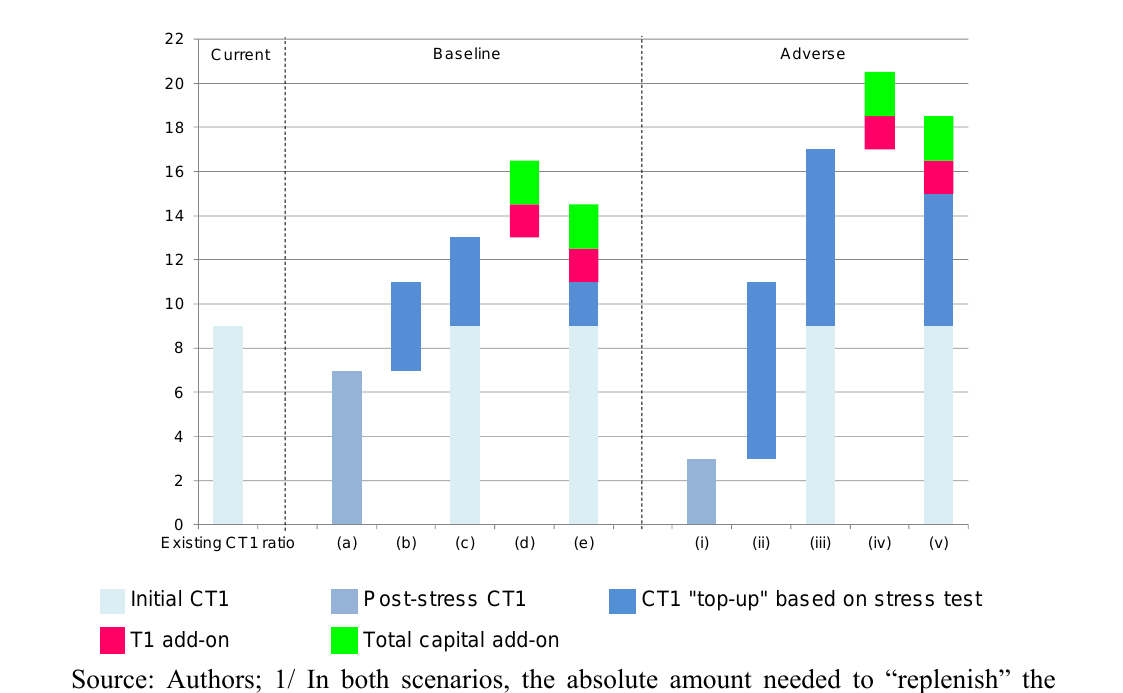
Box Figure 2. Hypothetical Recapitalization Estimations (In percentage points)